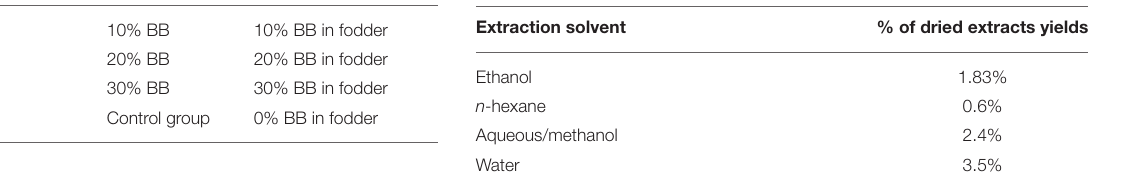
TABLE 2 | Study groups with percentages received, an in vivo experiment. TABLE 3 | The percentage yield obtained from the extraction of 1,010 gm of barley bran using the maceration method (% yield = weight after extraction/weight before extraction *